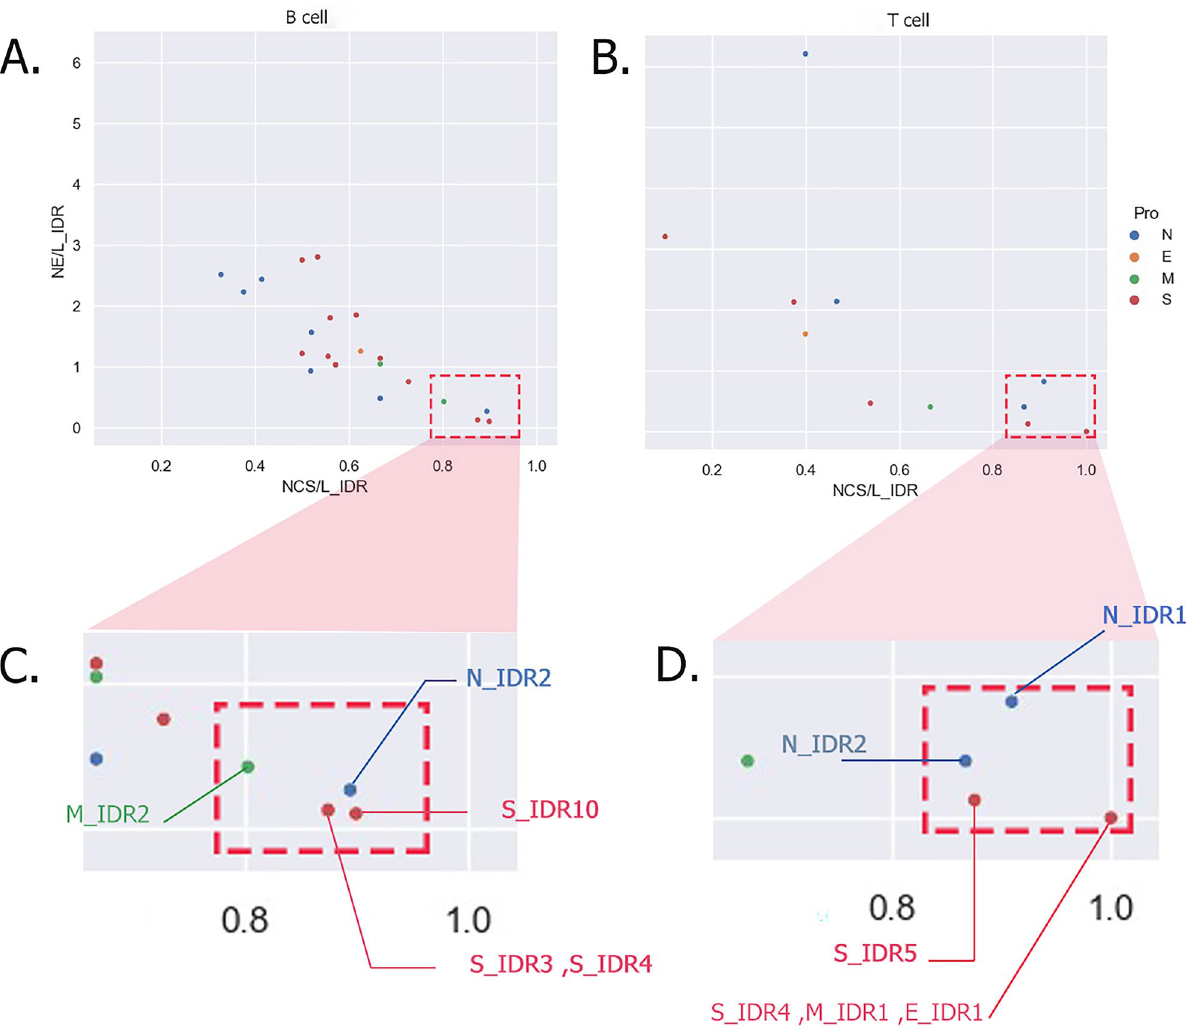
Figure 5. IDR plot. NE number of events, L_IDR length of IDR, NCS number of conserve sites. In panel ( A ) T cell IDRs are plotted with their number of events, their length and the number of conserve sites. As the number of conserved sites increases and the number of events decreases (Right Lower Quadrant), the IDR is more conserved in variants. Several T cell IDRs are selected as the most conserved IDRs (magnified in panel ( C )). In panel ( B ) B cell IDRs are plotted with the same parameters. Several B cell IDRs are selected as the most conserved B cell IDRs (magnified in panel ( D )). Here is to note that one dot in the plot can represent several IDRs that have the same normalized conserve sites and